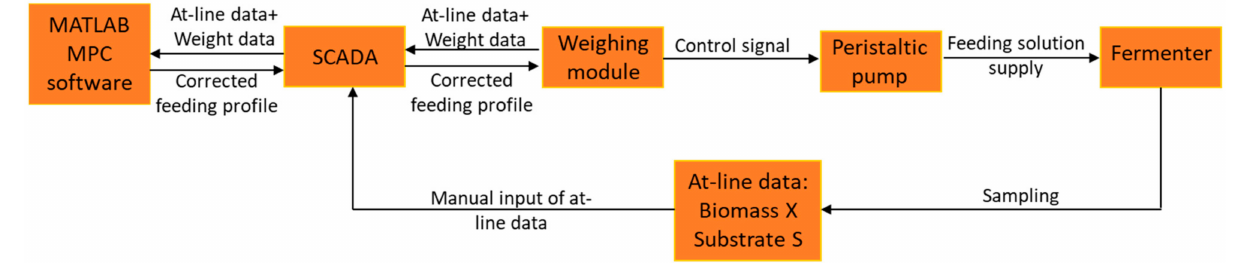
Figure 1. Communication (information exchange) diagram of the fed-batch control